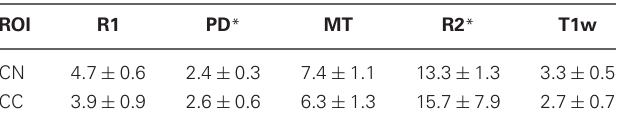
Table 3 | Group mean and standard deviation of the intra-site coefficient of variation (CoV) in percent for the parameter values and T1w image intensity in different